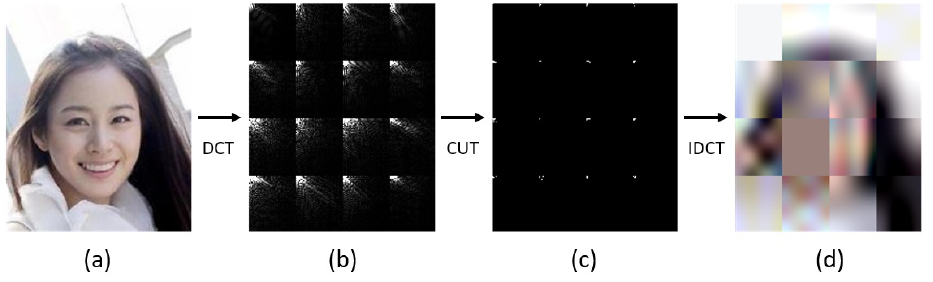
Figure 3. Three steps of the DCC process with a sample image from CelebA [37]. ( a ) Step 1 (DCT): The original image is divided into several blocks, and each block is transformed from the spatial domain to the frequency domain by DCT and displayed as the DCT coefficient matrix. ( b ) Step 2 (CUT): The DCT coefficient matrix is filtered by coefficient cutting methods, such that only a few high-frequency coefficients in the DCC coefficient matrix remain. ( c ) Step 3 (IDCT): The DCC coefficient matrix is transformed from the frequency domain to the spatial domain by I-DCT per block. ( d ) Then, the privacy-preserved image is